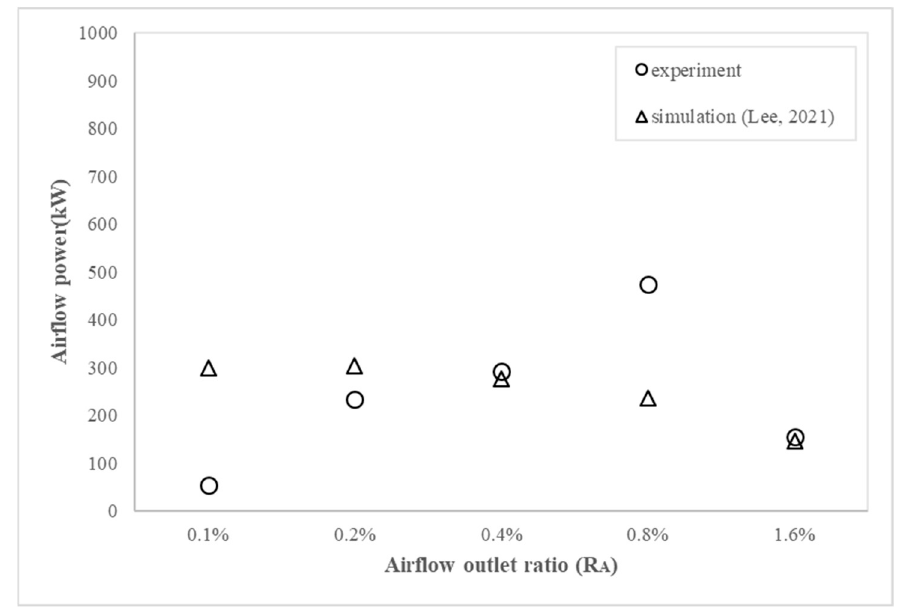
Figure 19. Comparison of the pneumatic power of air flow from the OWC various outlet ratios.